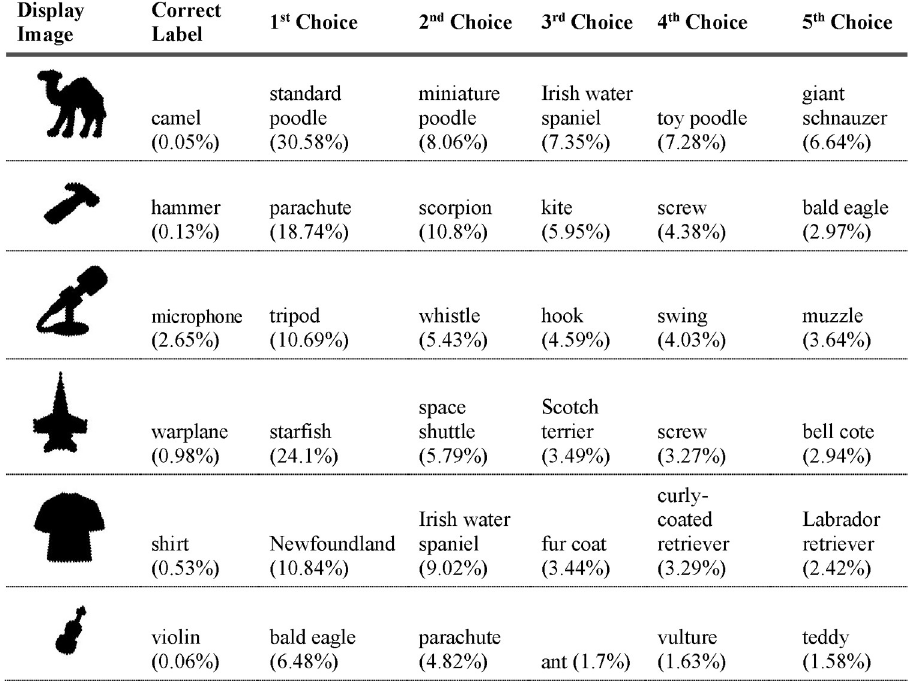
Fig 27. VGG-19 classifications for serrated edge silhouettes. The leftmost column shows the image presented to the DCNN. The second column shows the correct object label and the classification probability produced by the network for that label. The other five columns show probabilities for the network’s top five classifications, ordered left to right from highest to lowest. Correct classifications are shaded in blue.